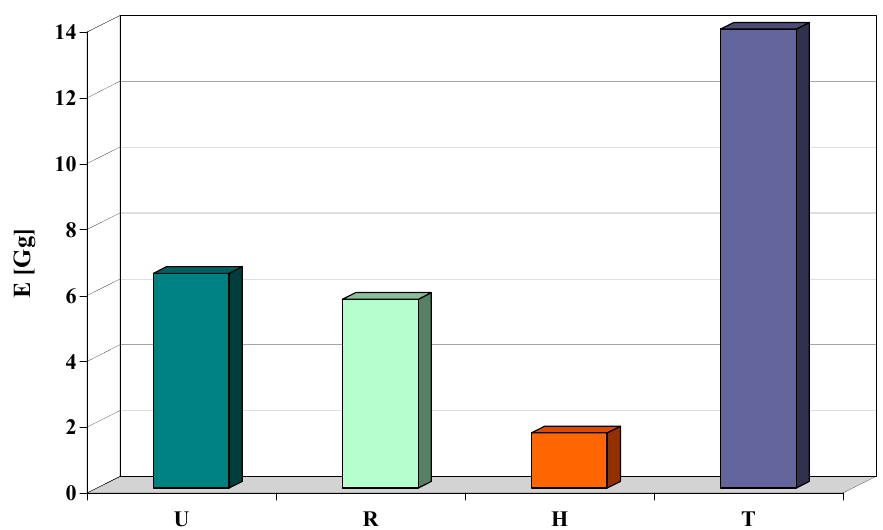
Figure 11. National annual emissions (E) of particulate matter PM2.5 (PM2.5-T) under different traffic conditions: urban (U), highway (H) and total (T).